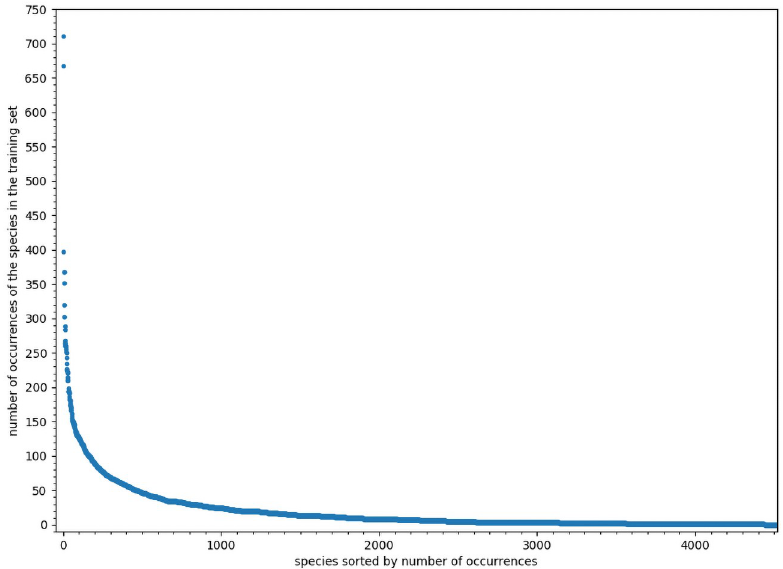
Fig 1. Occurrences’ distribution. Distribution of occurrences in the training set (including validation set), species are ordered by frequency.